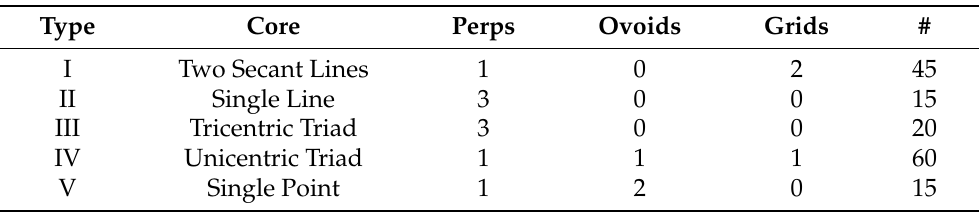
Table 1. An overview of the properties of the five different types of lines of V ( W ( 3,2 )) in terms of the core (i.e., the set of points common to all the three hyperplanes forming the line) and the types of geometric hyperplanes featured by a generic line of a given type. The last column gives the total number of lines per each type.